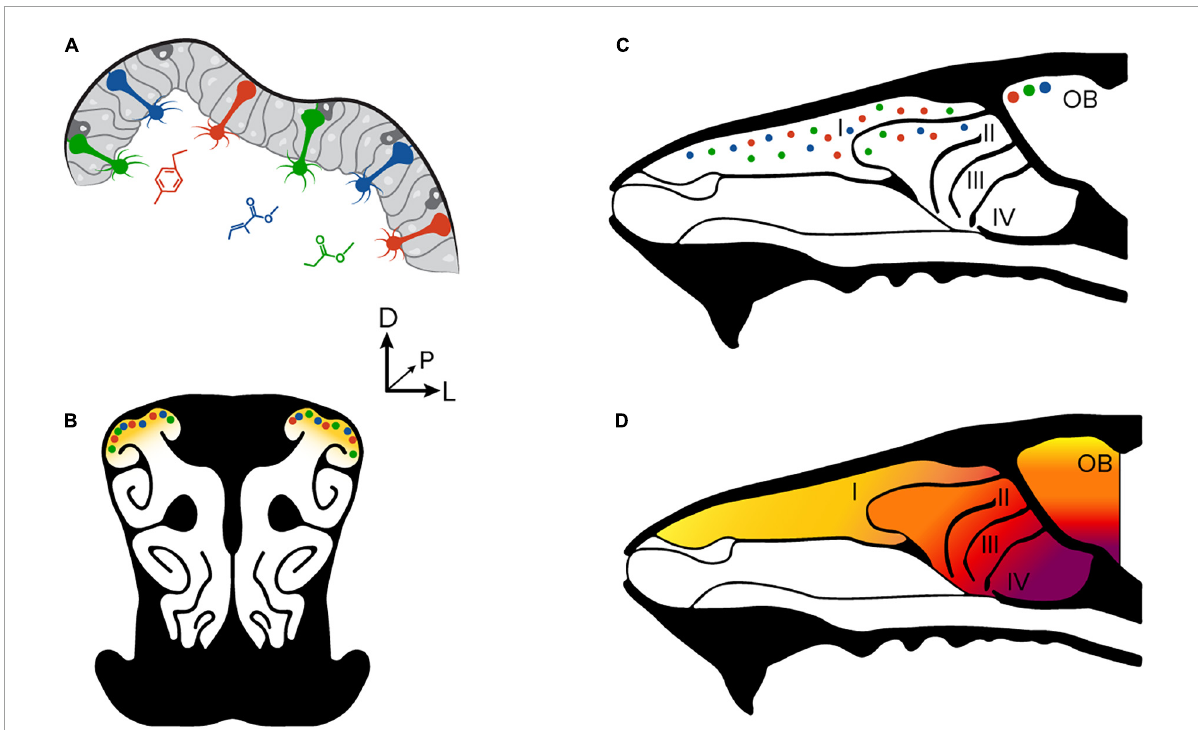
FIGURE1 Anatomical organization of the olfactory periphery. (A) Olfactory sensory neurons in the olfactory epithelium. Each sensory neuron is sensitive to a unique molecular feature of an odorant molecule. (B) A coronal section through the olfactory epithelium and nasal turbinates of a mouse. A large proportion of sensory neurons are found in the dorsal aspect of the turbinates. (C) A sagittal section at the midline through the nasal cavity and olfactory bulb. Olfactory sensory neurons found in the dorsal epithelium project to glomeruli on the dorsal surface of the olfactory bulb. Modified from Zak et al. (2020). (D) The zonal organization of the olfactory epithelium is consistent with glomerular placement in the olfactory bulb. The OSN subtypes found in the dorsal epithelium project their axons to the dorsal olfactory